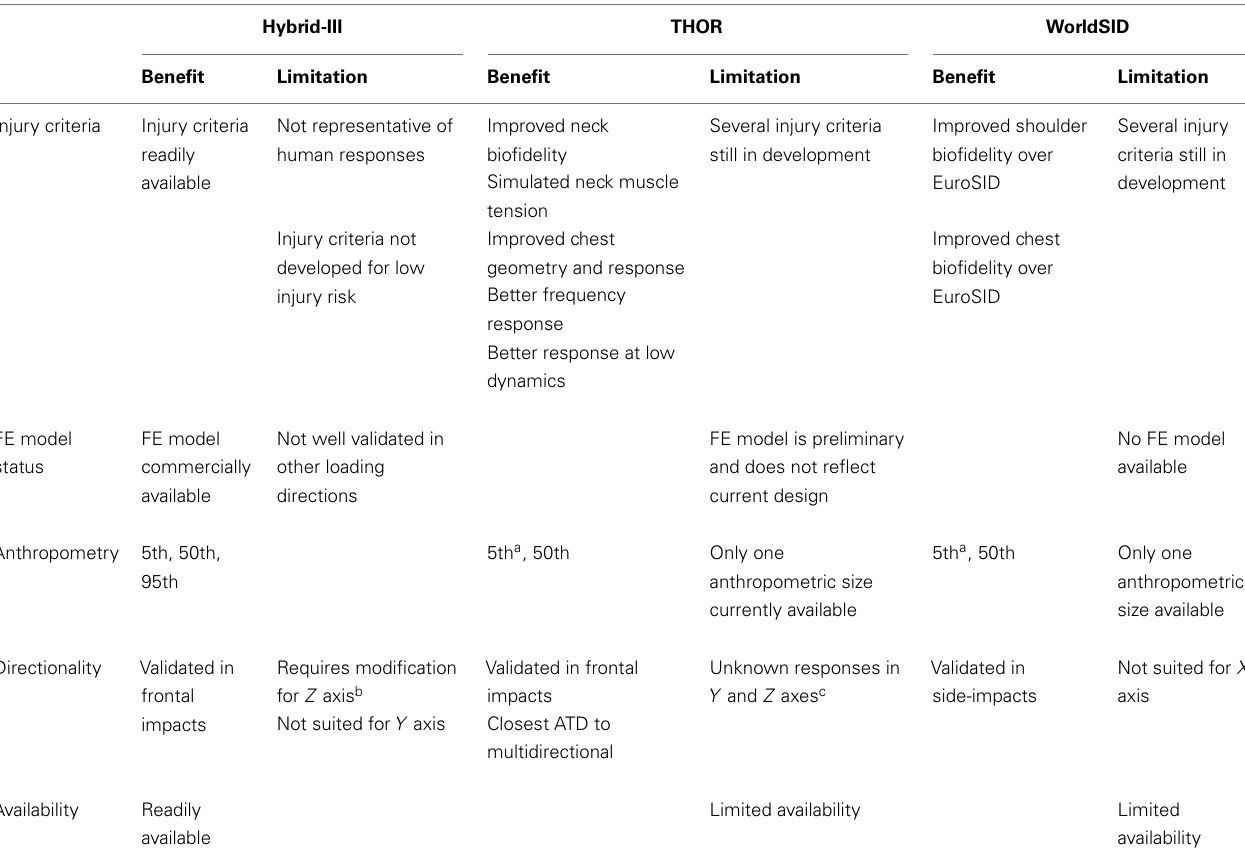
Table 4 | Benefits and limitations of eachATD.